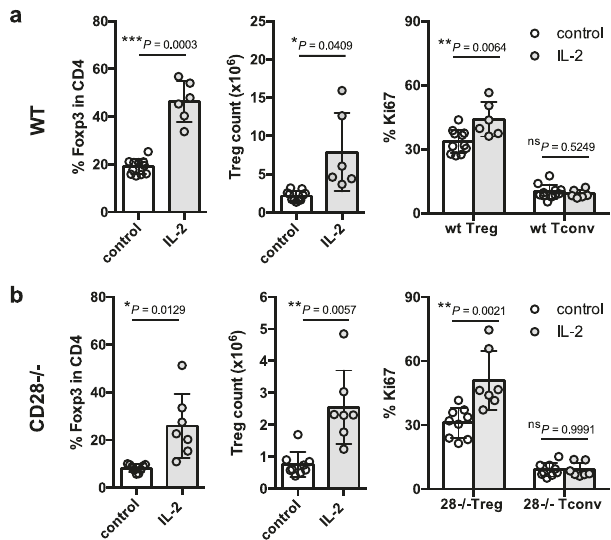
Fig. 2 | IL-2 promotes Treg homeostasis in CD28-de fi cient mice. 6 – 8 week old BALB/c and CD28 − / − micewere injectedi.p. with IL-2 complex or control on d0,d2, d4,d6andd7.Atd8,spleencellswereharvestedforanalysis.Graphsshowcollated data for Treg percentage in CD4+cells (left), Treg absolute number (middle) and Ki67expressiononTregorTconv(right)fromtreatedBALB/c a ,orCD28 − / − b mice. Dataarepresentedasmean±s.d.;eachdotindicatesonemouse. a n =11forcontrol, n =6 for IL-2; ( b ) n =9 for control, n =7 for IL-2. Data are collated from 5 inde- pendent experiments. * P <0.05, ** P <0.01, *** P <0.001, ns not signi fi cant (two- tailed t test). Source data are provided as a Source Data fi